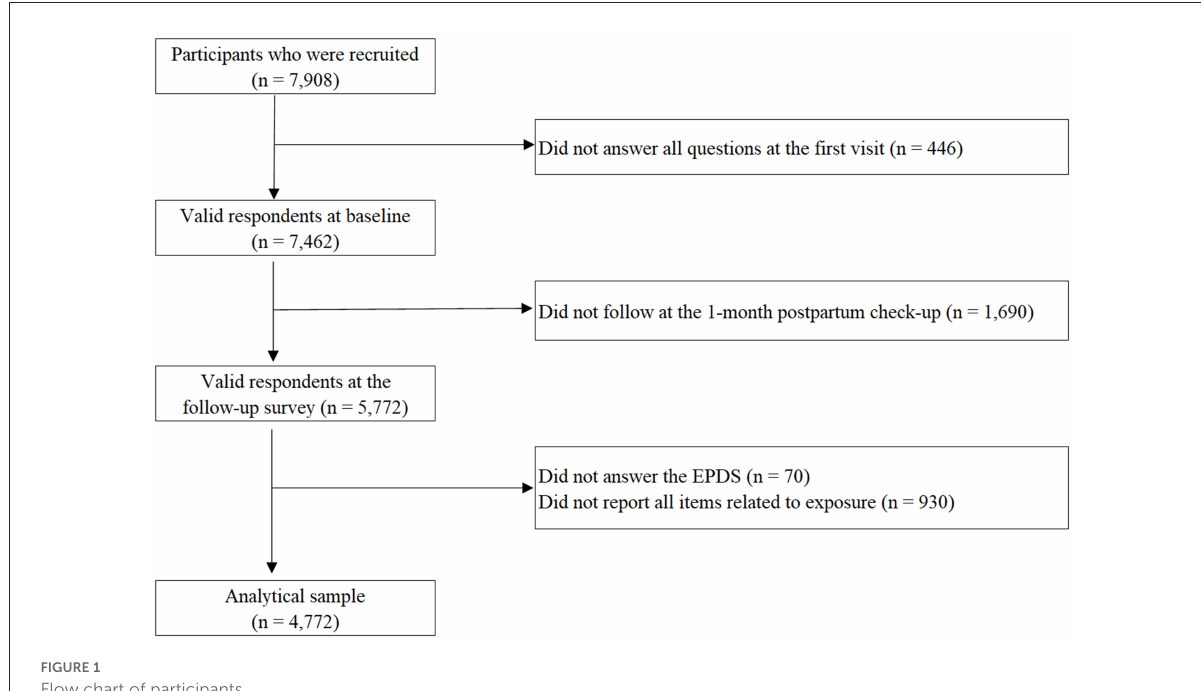
FIGURE1 Flow chart of